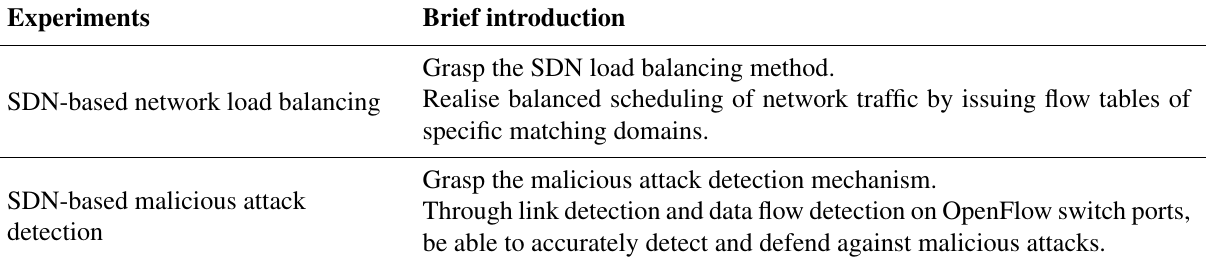
Table 3 Synthesis experimental